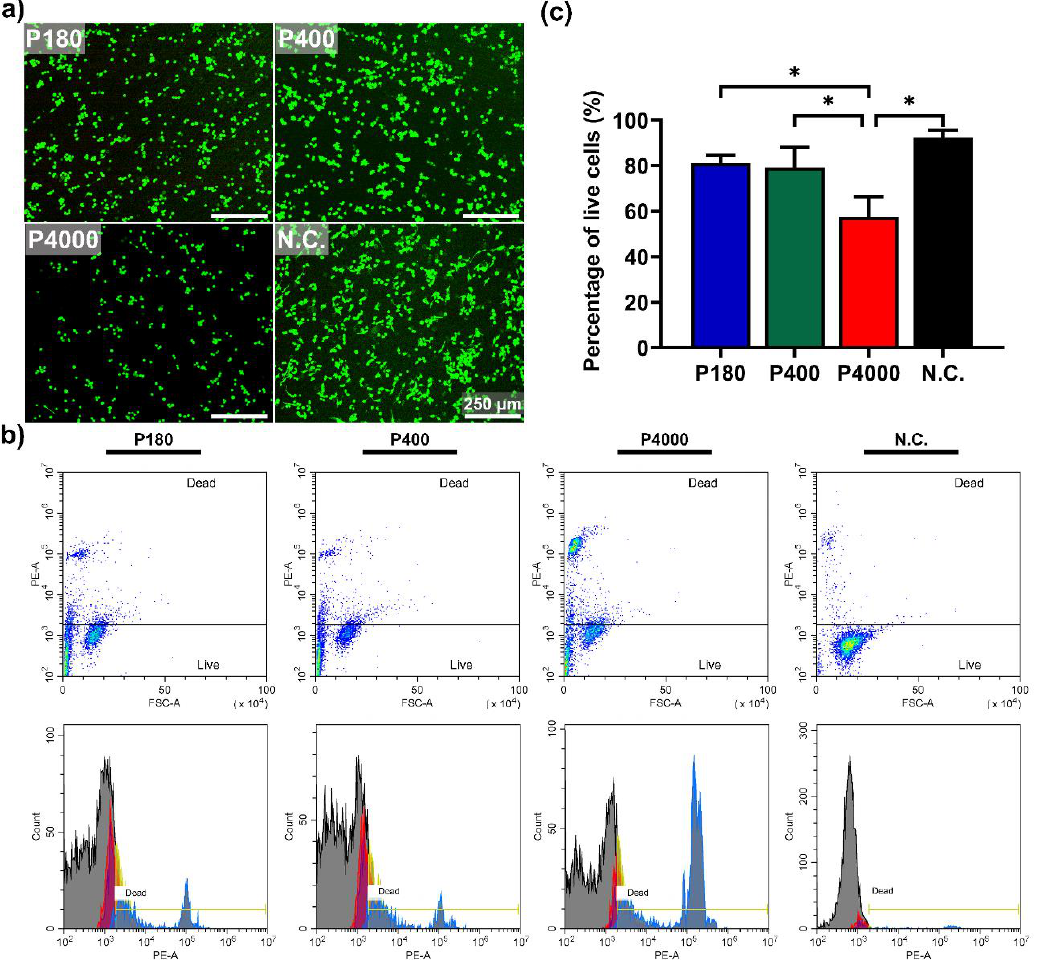
Figure 5. Direct contact test of sample with different roughness. ( a ) Fluorescent staining images of RAW264.7 cultured on sample surfaces (magnification 100 × , scale bar = 250 μm ). ( b ) The result of flow cytometry, suggesting cell apoptosis of RAW264.7 directly cultured on sample surface, determined by PI staining. ( c ) The quantitative results of cell viability. Titanium-based alloy was set as a negative control (N.C.). * represents a statistical difference between the two groups.